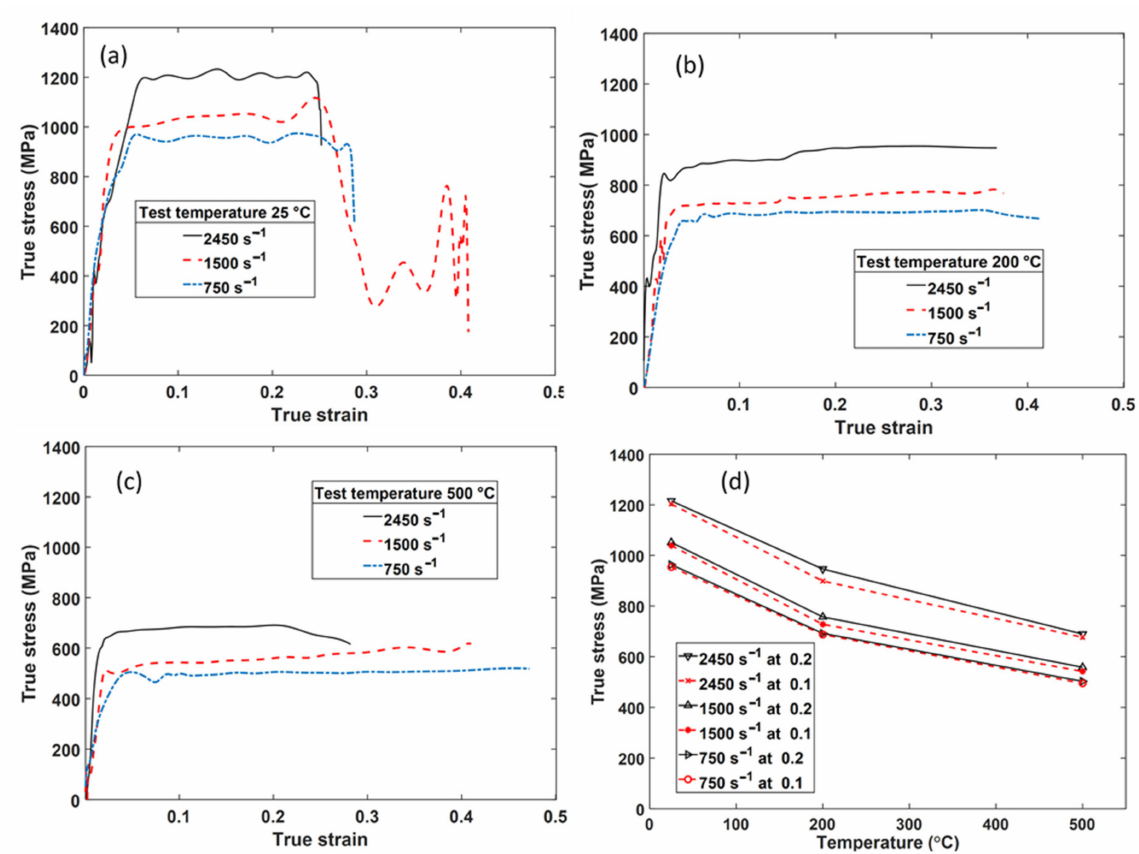
Figure 7. The true stress–strain curves ( a – c ) at different strain rates and temperatures, and ( d ) true stress vs. temperature curves at different strain rates and at strains of 0.1 and 0.2, all for samples